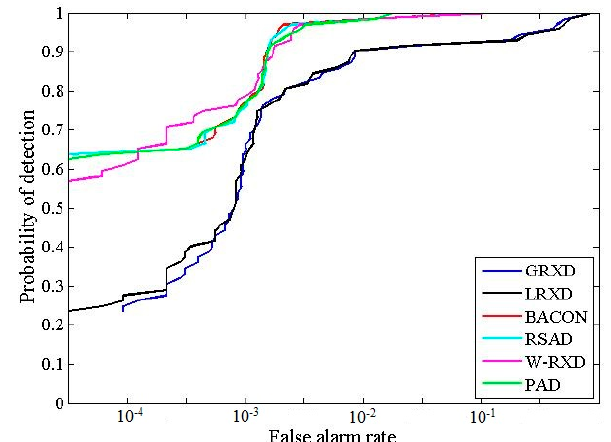
thresholds. The ratio of anomaly was set to 1%.